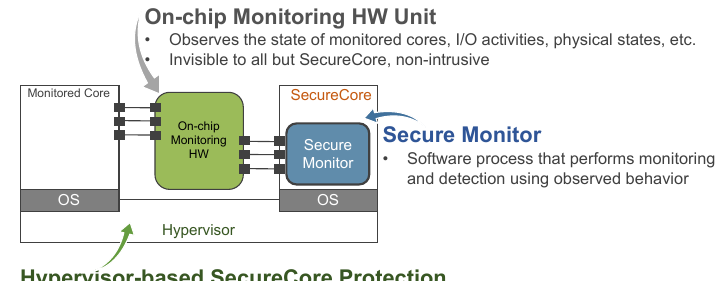
Figure 5. An illustration of SecureCore framework. The trusted core is used to monitor the behavior of the complex (and potentially vulnerable) core used for executing application/control